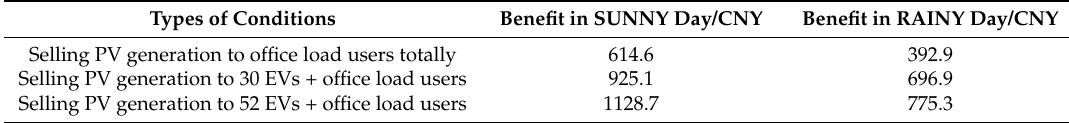
Table 3. Benefits of PV owners for three conditions.